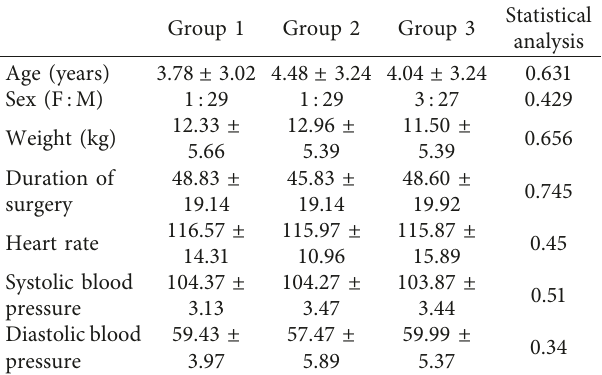
Table 3: Demographic distribution and baseline vitals.